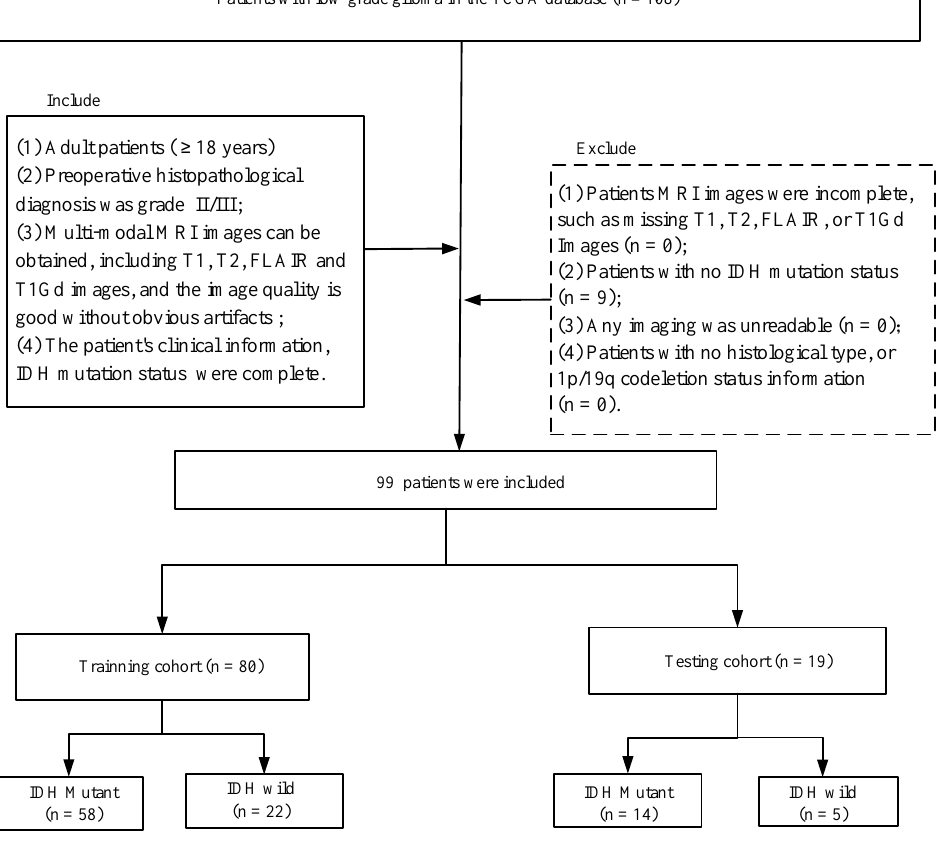
Figure 1. Patient screening flowchart. Abbreviations: TCGA, The Cancer Genome Atlas; T1, T1- weighted; T2, T2-weighted; FLAIR, fluid-attenuated inversion recovery; and T1Gd, post-contrast T1-weighted.